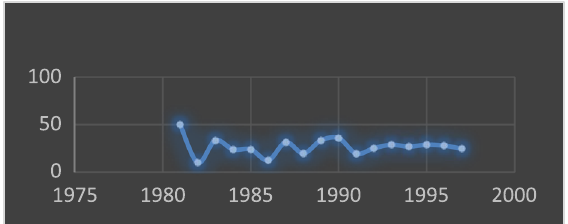
Fig. 3. Trend of WACS passrate_Part I.